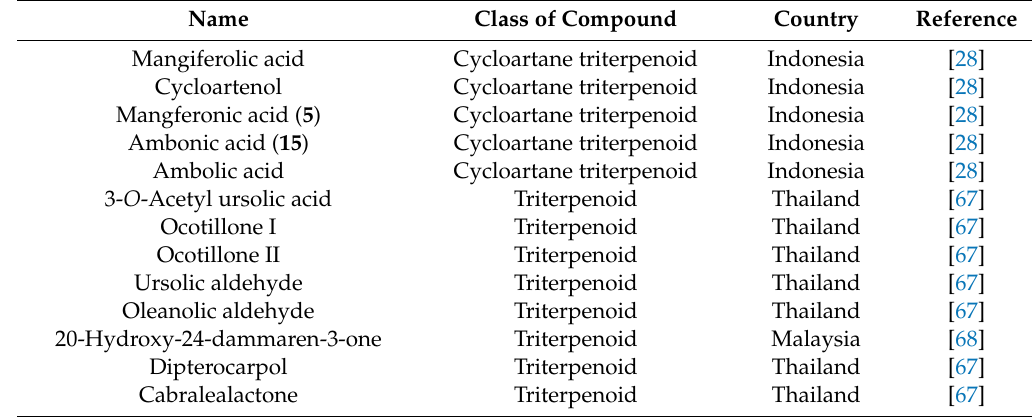
Table 3. Some compounds isolated from Asian propolis between 2015 and